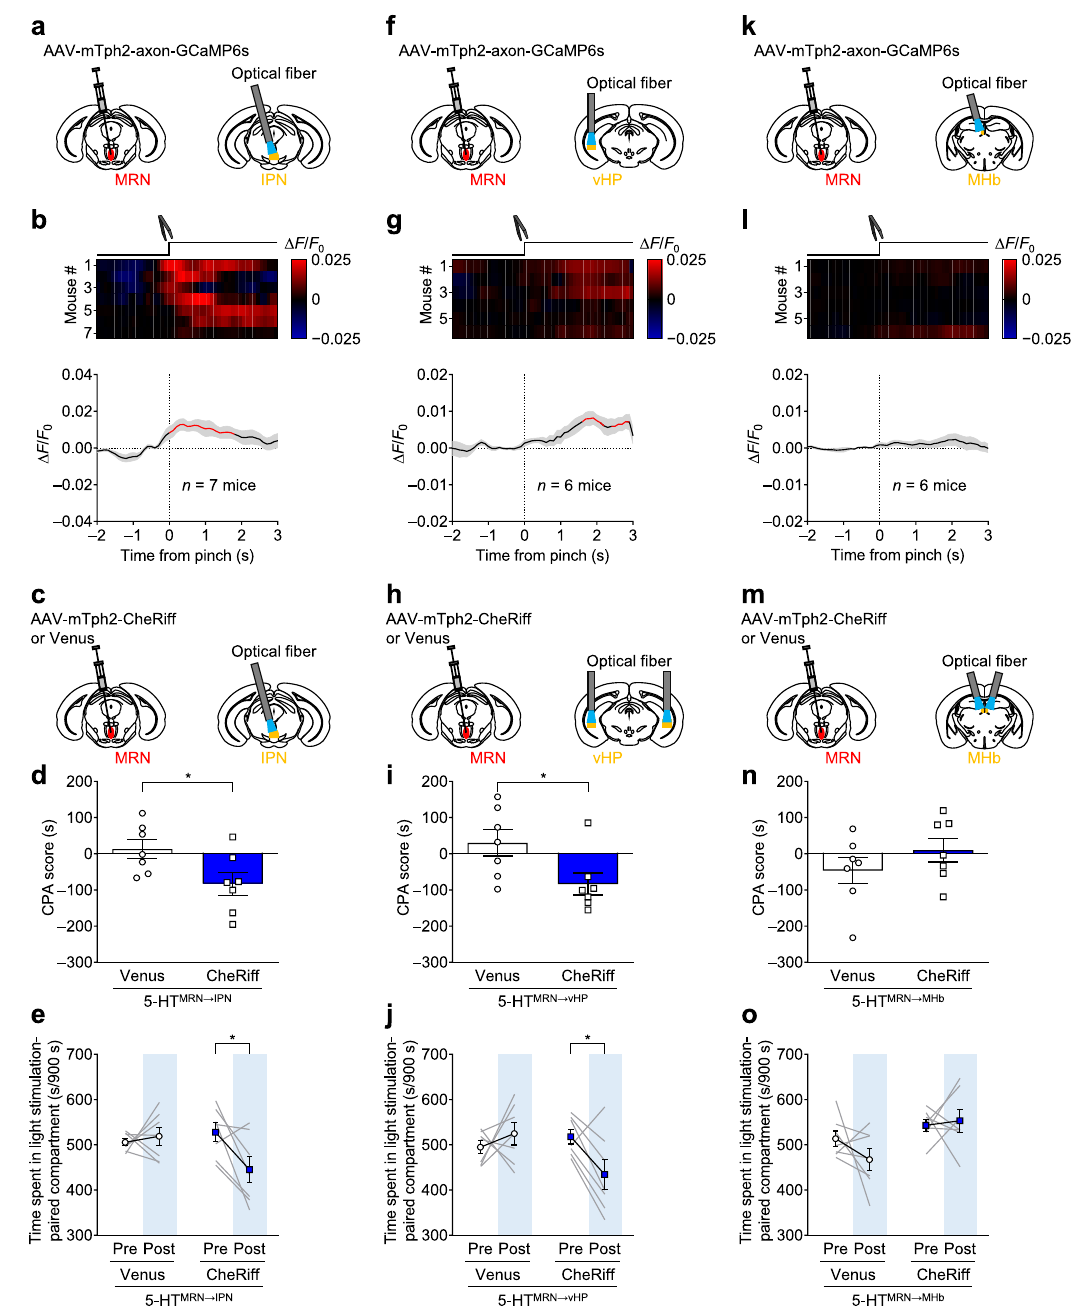
Fig.7|AversivestimuliactivateserotonergicneuronsfromtheMRNtoIPNand vHP, and their activation elicits CPA. a , f , k Schematic representation of